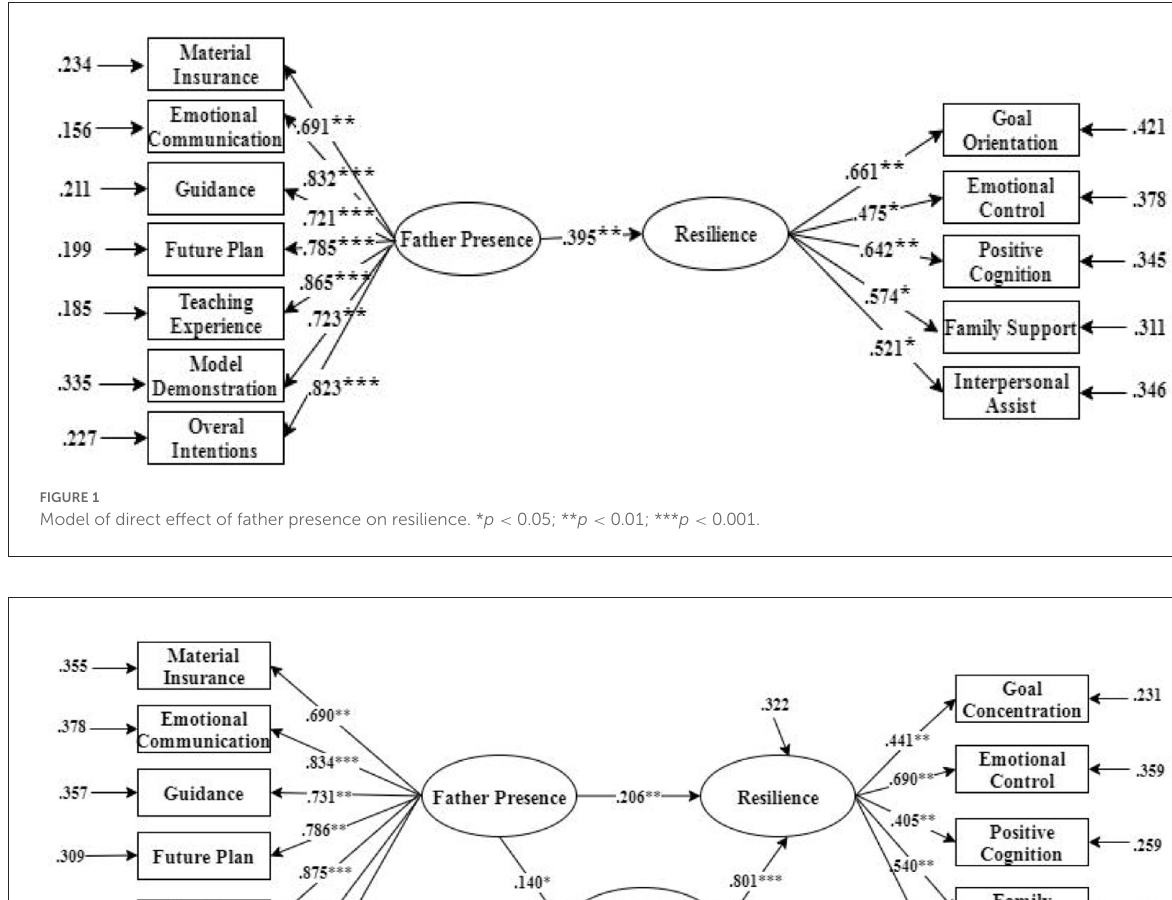
psychological security ( r = 0.312